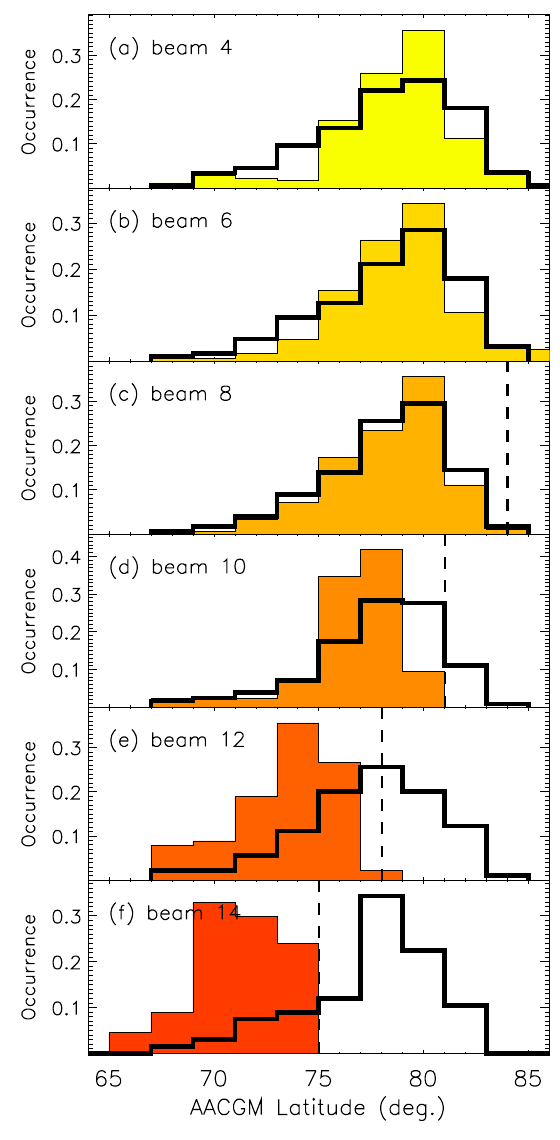
Fig. 3. Percentage occurrence distributions of the latitudinal lo- cations of the SWB determinations (shaded histograms) and the DMSP OCB determinations (bold black histograms) for the dif- ferent beams from the Goose Bay radar for the 1000–1400 MLT region. The distributions come from (a) beam 4, (b) beam 6, (c) beam 8, (d) beam 10, (e) beam 12, and (f) beam 14. The dashed vertical lines represent the maximum possible SWB latitudes for beams